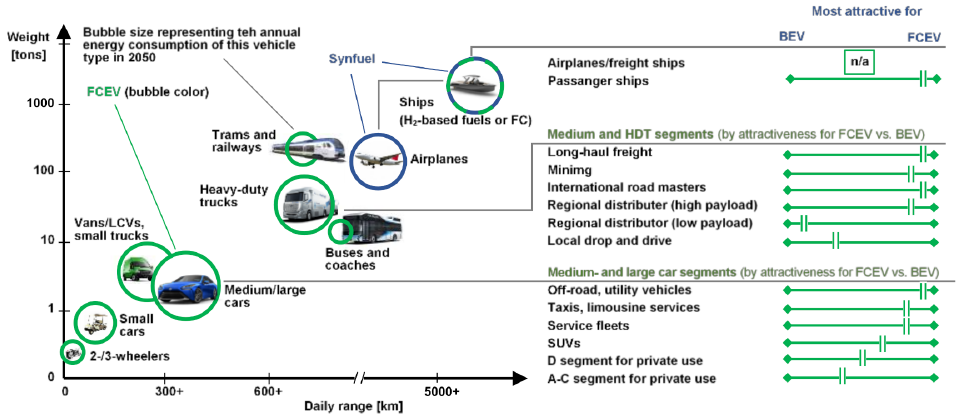
Figure 1. Comparison of range and payload for hydrogen and battery technology in means of transportation